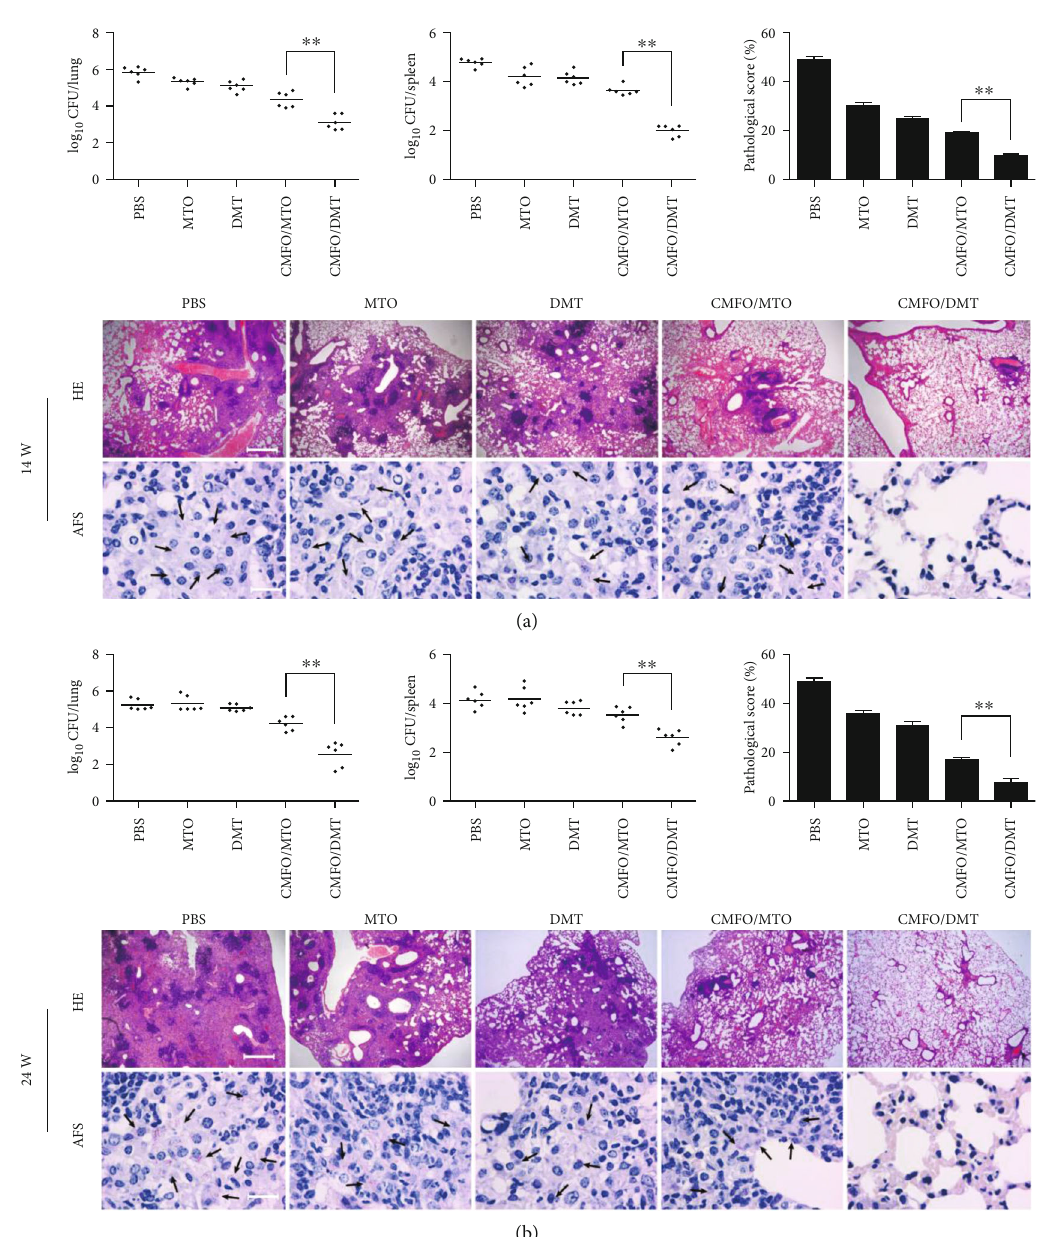
Figure 4: Short-term and long-term protection e ffi cacies between di ff erent vaccinated groups. Vaccination and challenge schedule. At the 14th (a) and 24th weeks (b), bacterial load in the lung and spleen per organ was enumerated. The results were shown as the mean ± SEM log CFU ( n = 6 ). Representative histopathological photographs of the lung and lung histopathological score ( n = 3 ) from short-term and 10 long-term experiments were also provided. HE staining, scalebar = 500 μ m and AF staining, scale bar = 20 μ m . Arrowheads indicate AF positive bacteria. ∗∗ p < 0 : 001